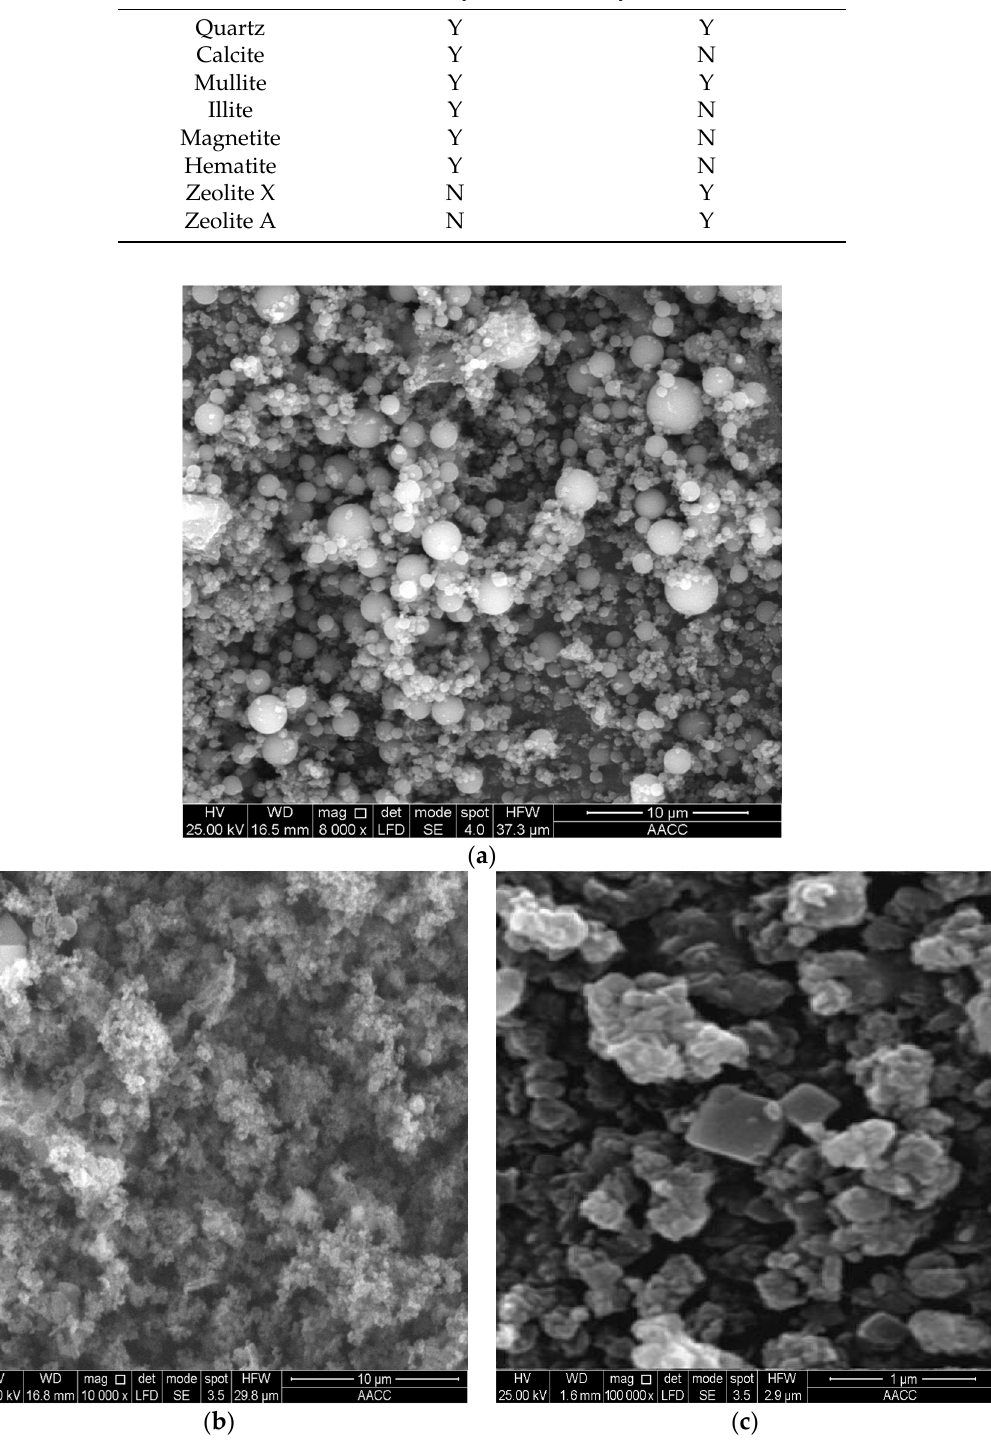
Figure 5. Scanning electron microscope (SEM) of coal fly ash and synthesized zeolite ( a ) coal fly ash; ( b ) synthesized zeolite; ( c ) crystal structures in synthesized zeolite.